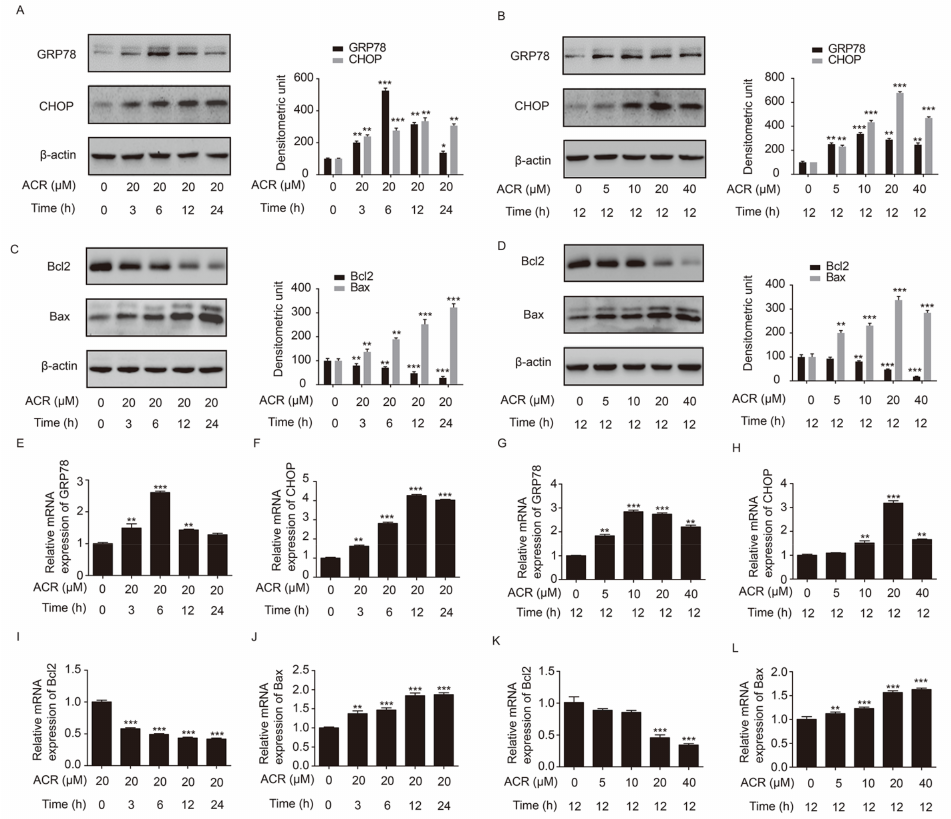
Figure 5. Acrolein altered the expression of GRP78, CHOP, Bcl2 and Bax in H9c2 cells. ( A , C , E , F , H , I ) The expression of GRP78, CHOP, Bcl2 and Bax at the protein and mRNA levels after H9c2 cells were treated with acrolein (20 µ M) for the indicated time points (0, 3, 6, 12, 24 h), as measured by Western blotting and qRT-PCR; ( B , D , G , H , J , K ) The expression of GRP78, CHOP, Bcl2 and Bax at the protein and mRNA levels after the H9c2 cells were treated with acrolein (0, 5, 10, 20, 40 µ M) for 12 h, as measured by Western blotting and qRT-PCR. * p < 0.05, ** p < 0.01 and *** p <